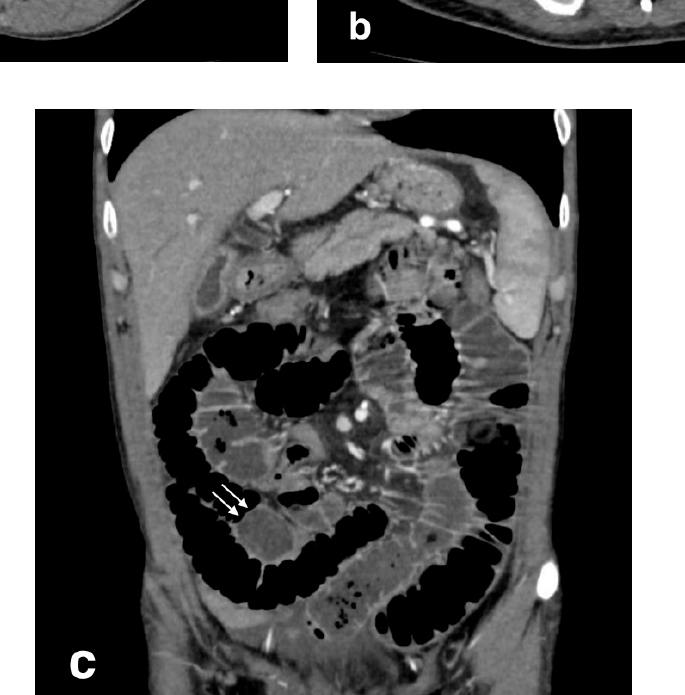
with the presence of air in the gallbladder lumen (arrowhead); ( b ) axial image shows a large gallstone